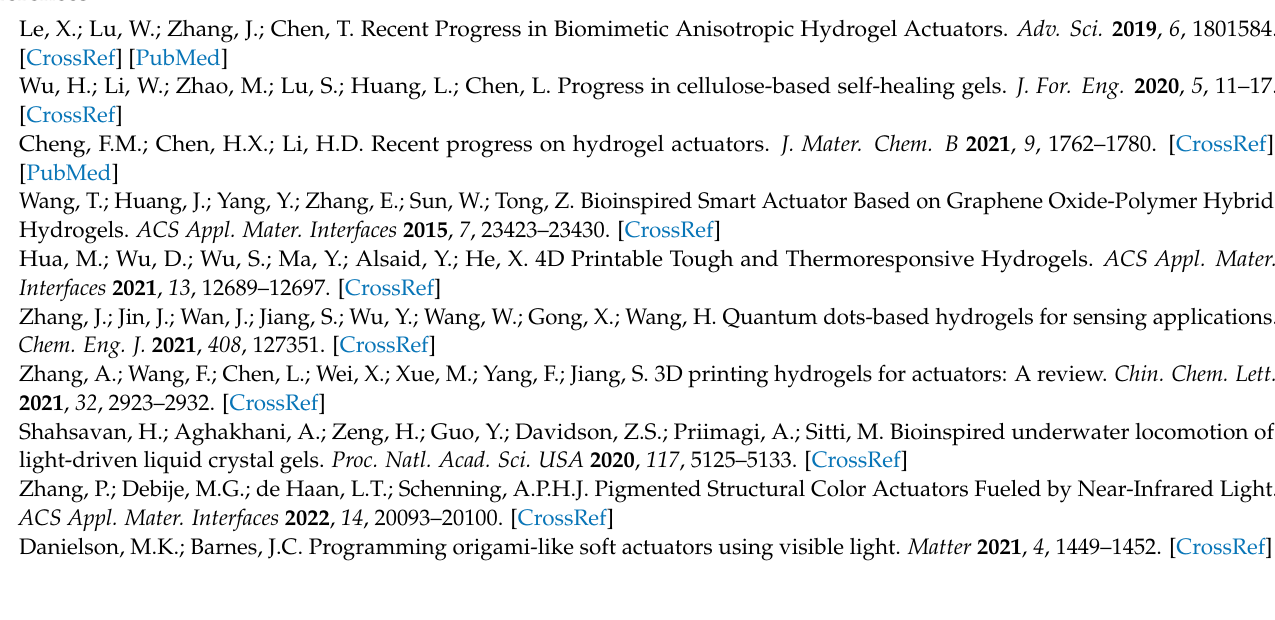
hydrogel. Figure S2. Mechanical property of the original white tissue paper. Figure S3. Mechanical property of the original black tissue paper dyed by the printer. Figure S4. The DSC curve of the PNIPAM hydrogel. Figure S5. The bending process of the tissue paper/hydrogel composite actuator under 45 ◦ C warm water. Figure S6. The bending–recovering cycle performance test of the tissue paper/PNIPAM hydrogel composite actuator. Movie S1. Bending–recovering process of the composite actuator under an area irradiation (with 3.5 w/cm 2 intensity of an 808 nm laser lamp). Movie S2. Folding–recovering process of the composite actuator under a point irradiation (with a 0.2 cm spot diameter and 2 W of power by an 808 nm laser lamp). Movie S3. The remotely controlled light-responsive grabbing behavior of the biomimetic “paw” based on the composite actuator under an area irradiation (with 3.5 W/cm 2 intensity of an 808 nm laser lamp). Movie S4. The remotely controlled light-responsive finger-folding performance of the biomimetic “hand” based on the composite actuator under a point irradiation (with a 0.2 cm spot diameter and 2 W of power by an 808 nm laser lamp, 63.9 W/cm 2